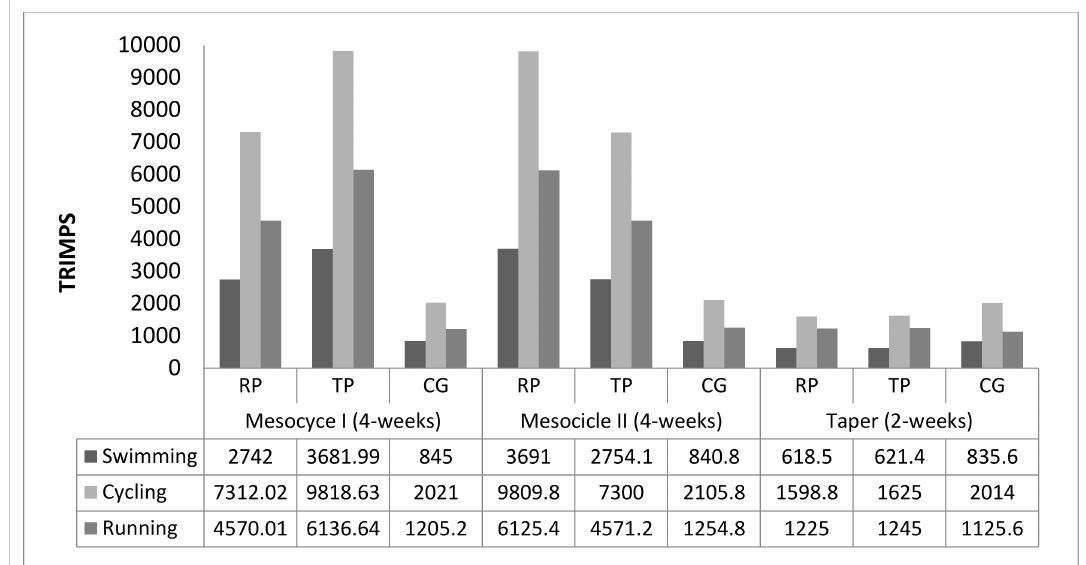
Figure 1. Training impulse (TRIMP) of reverse training periodization group (RP), traditional linear periodization group (TP), and control group (CG) during the three mesocycles of the 10-week macrocycle of training according to the three